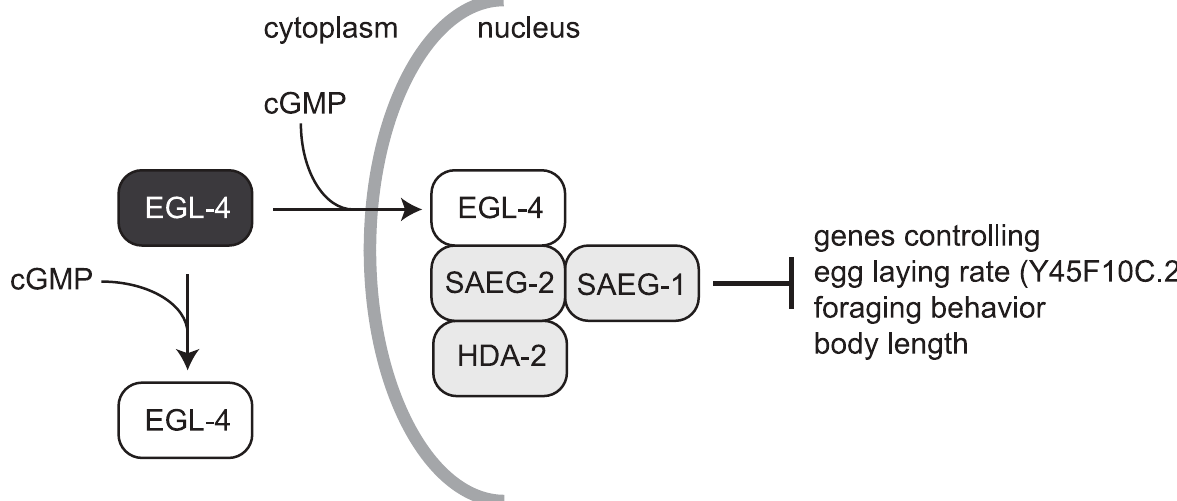
Figure 6. Genomic effects of activated nuclear EGL-4 are mediated by the SAEG-1/SAEG-2/HDA-2 complex.